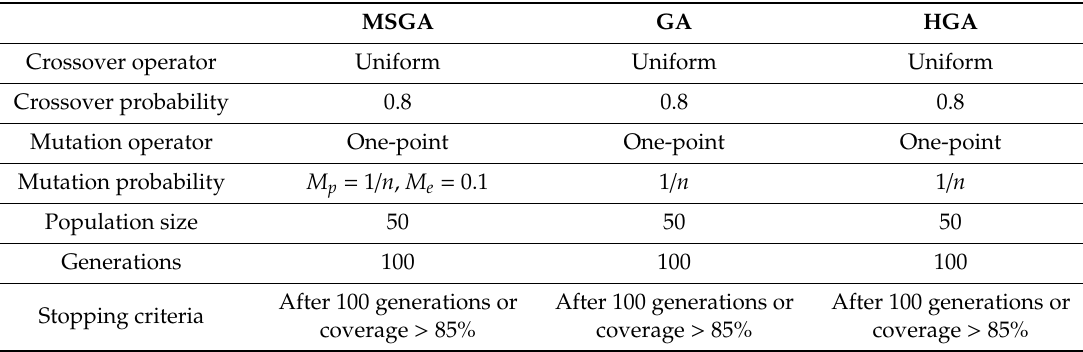
Table 9. Parameter settings for performance comparison. Note: M p and M e indicate mutation probability of conservative and explorer chromosomes, respectively. MSGA GA